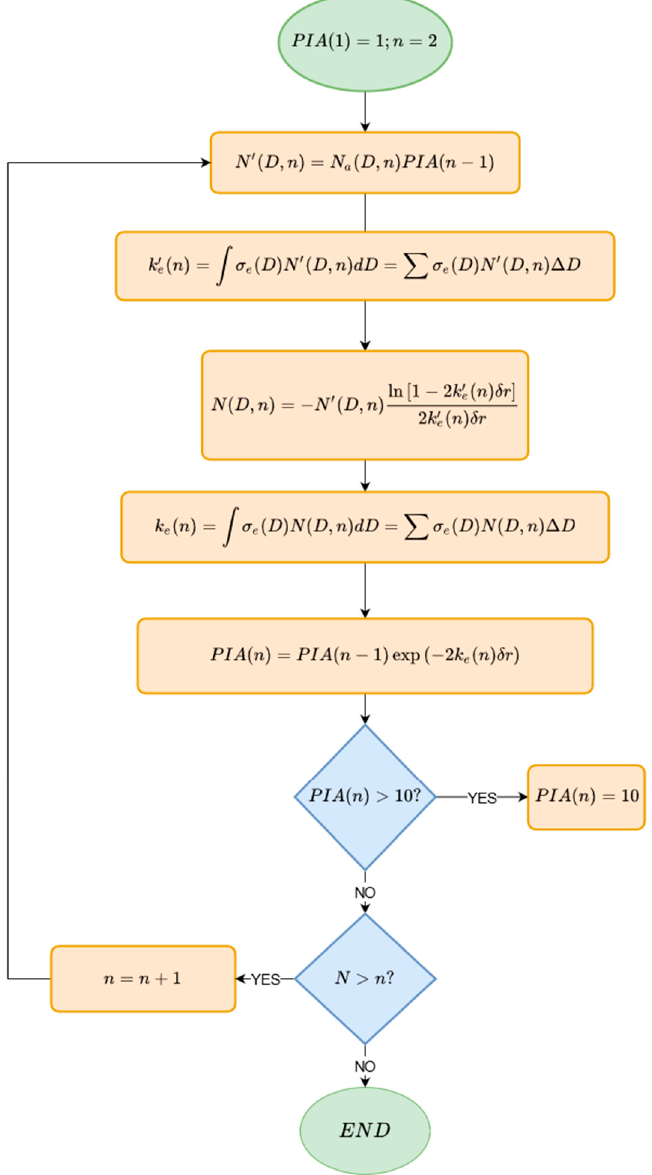
Figure 7. PIA calculation flow chart adapted from [36]. N’ ( D , n ) and Na ( D , n ) are, respectively, the drop size distribution and the attenuated drop size distribution; k e is the specific rain attenuation and σ e is the single-particle extinction coefficient, calculated with the Mie theory.